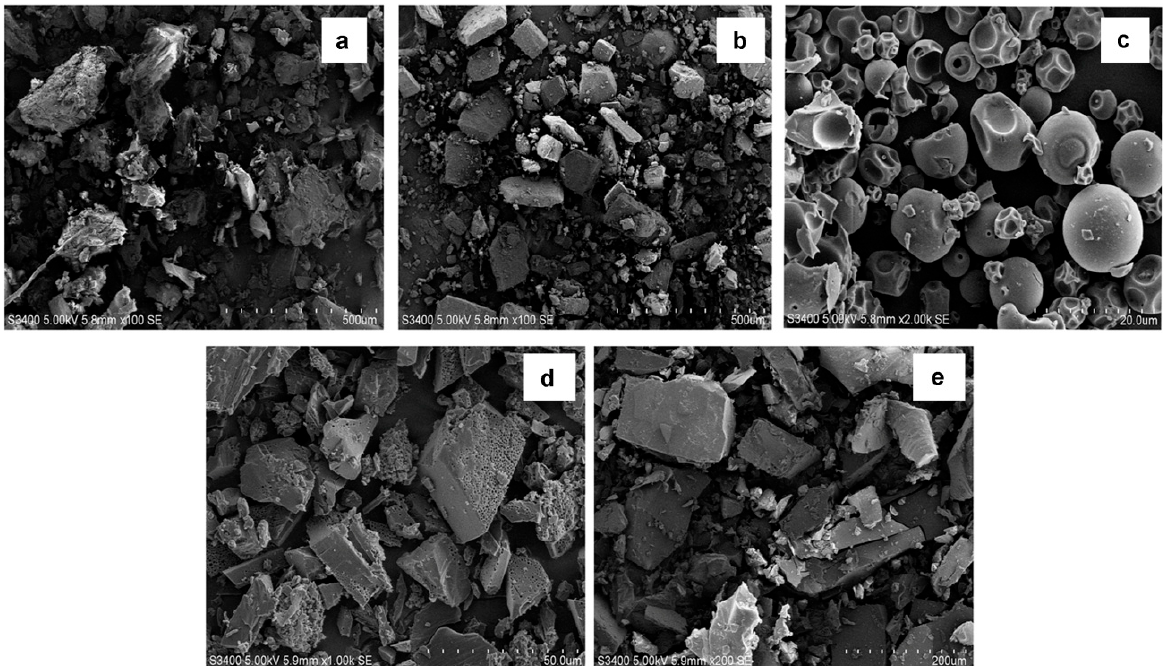
Figure 5. SEM of ( a ) RBG, ( b ) β -CD, ( c ) HP- β -CD, ( d ) RBG/ β -CD complex, and ( e ) RBG/HP- β -CD